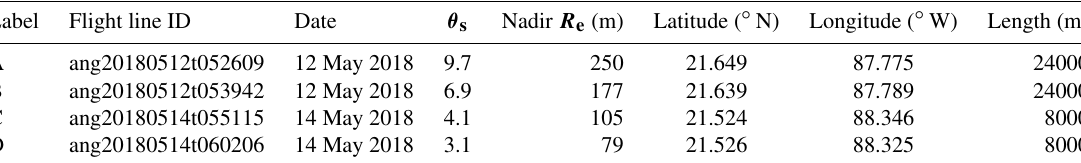
Table 1. Flight lines used for structure function analysis.